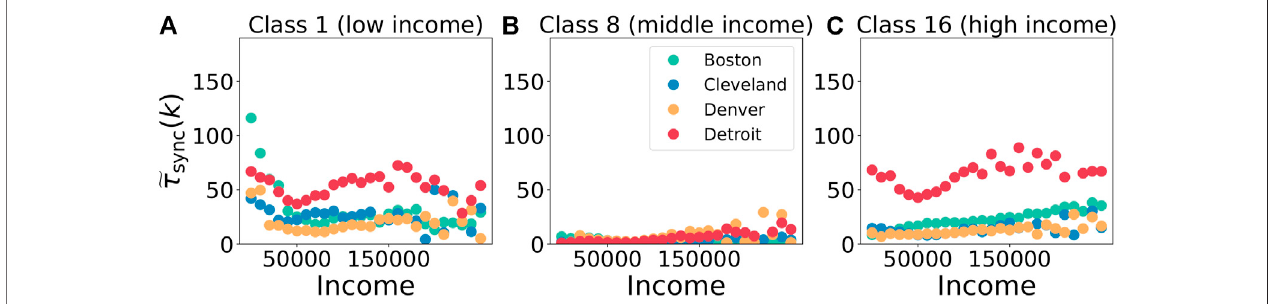
FIGURE5 | Synchronization time and median income. Normalized synchronization time asa function ofthe median incomeaveraged over bins of$5,000 forclass 1 (A) , class 8 (B) and class 16 (C)